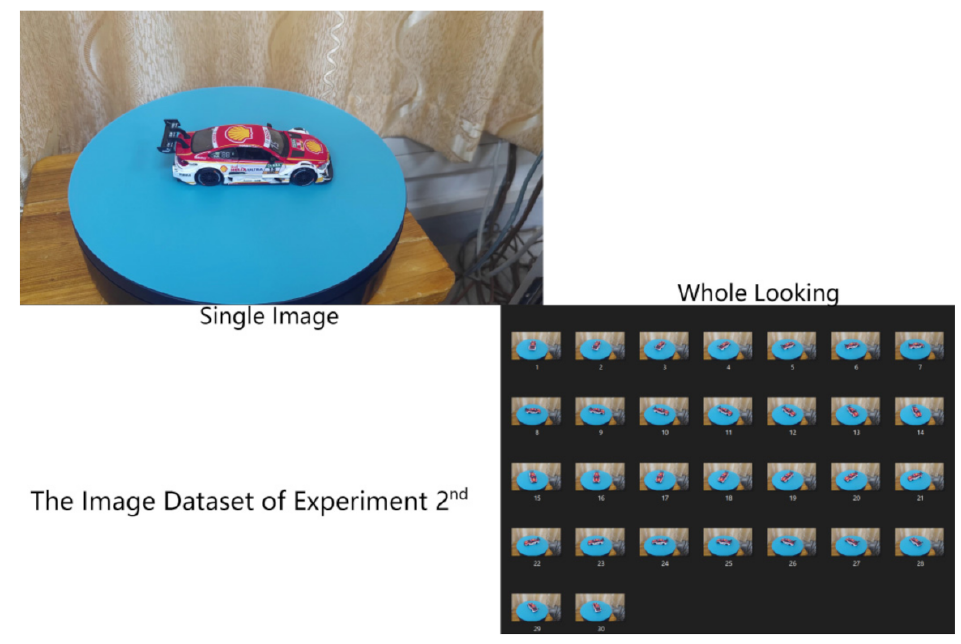
Figure 16. The image dataset used in experiment 2.